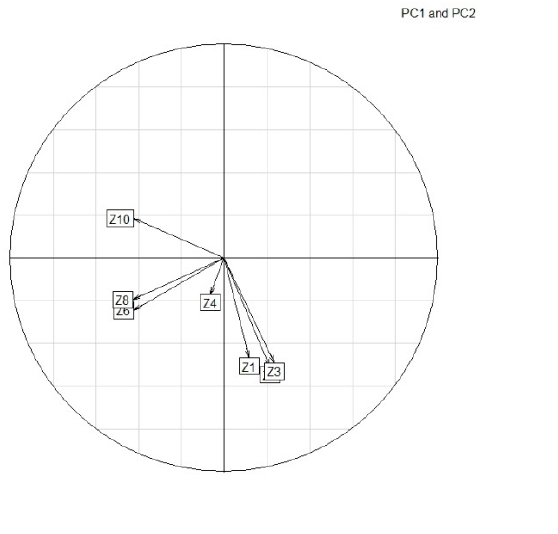
Figure 3. Biplot graphics for input parameters (with PC1 as X-axis). ( a ) PC1 vs. PC2. ( b ) PC1 vs. PC3.